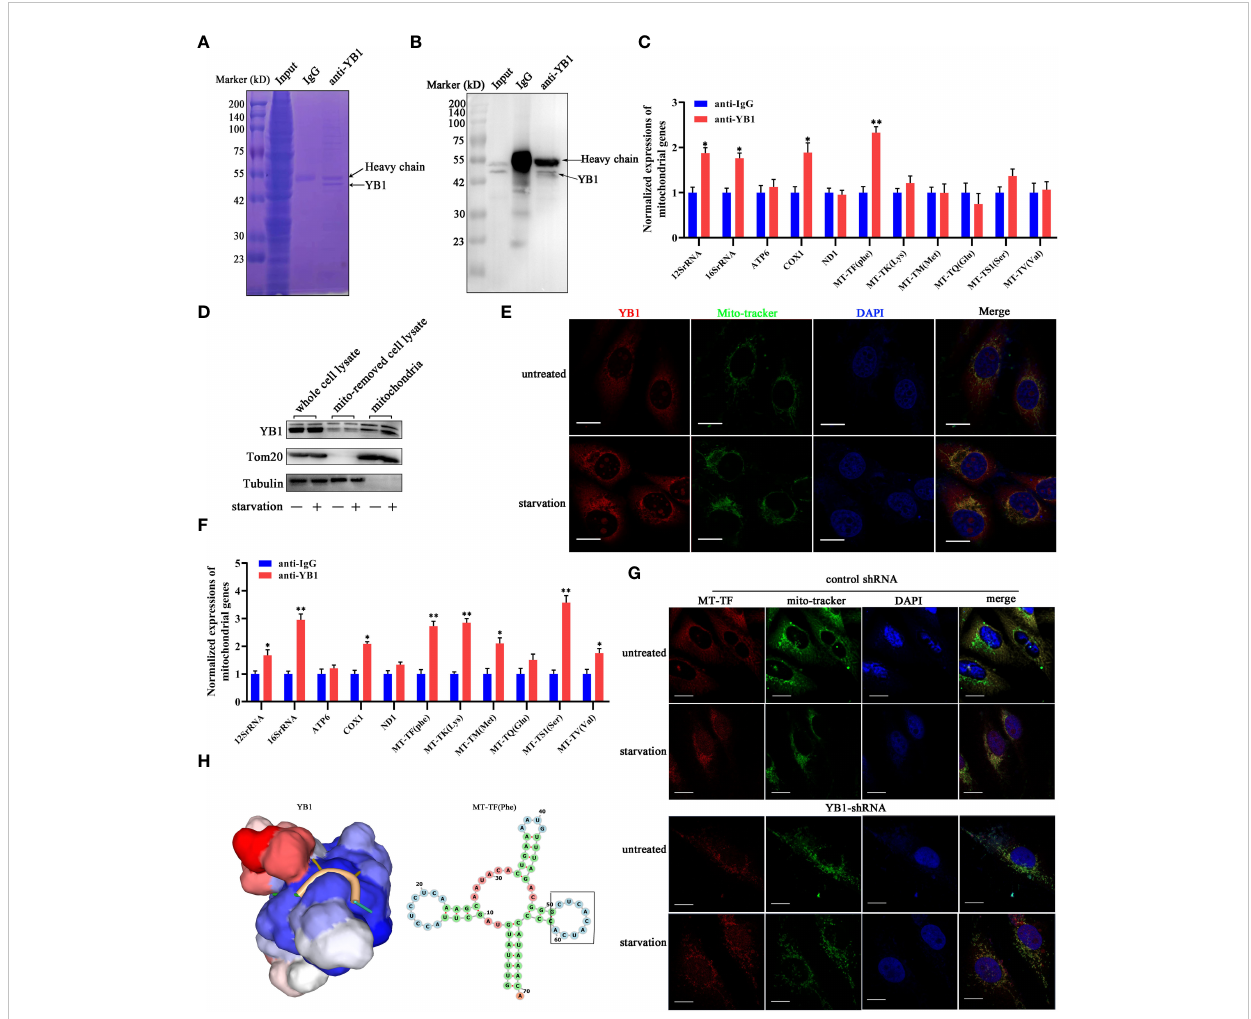
FIGURE 4 YB1 interacted with mitochondrial tRNA. (A, B) RNA-associated immunoprecipitation (RIP) assays. RIP was conducted in MDA-MB-231 cells to sediment the YB1 – RNA complex; rabbit IgG was used as a negative control. The contents of immunoprecipitate were analyzed by SDS-PAGE with Coomassie staining (A) or Western blot (B) . (C) Detection of mitochondrial RNA in the YB1-immunoprecipitated complex. The RNAs co- immunoprecipitated with YB1 proteins were isolated and detected using quantitative real-time PCR. YB1 distribution was detected using the mitochondrial fraction (D) and immuno fl uorescence (E) ; scale bar, 10 m m. (F) Serum-free starvation treatment increased the direct interaction between mitochondrial RNA and YB1 protein. n = 3, **p < 0.01, *p < 0.05. (G) MT-TF distribution detection using FISH. After starvation treatment, more MT-TF (red) were localized in the outside of mitochondria. Scale bar, 10 m m. (H) A YB1 – RNA interaction model was built using the online